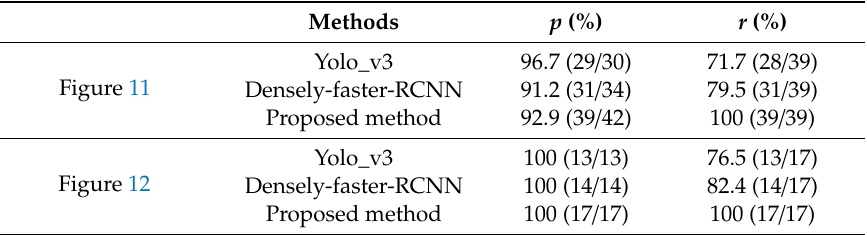
Table 2. Detection performance